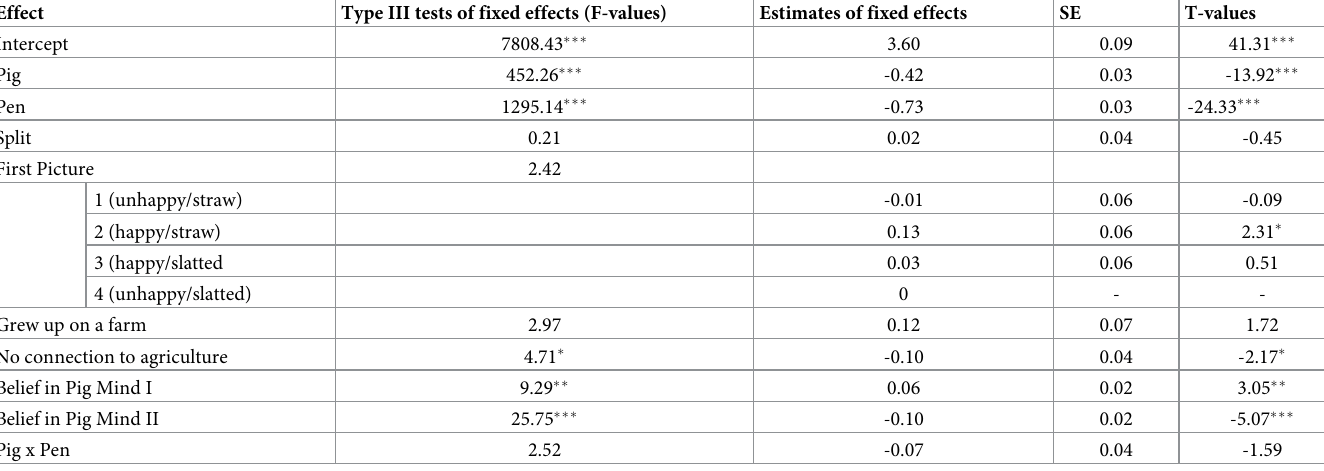
Table 6. Type III tests and estimates of fixed effects in the linear mixed model on pig evaluation in the pictures.